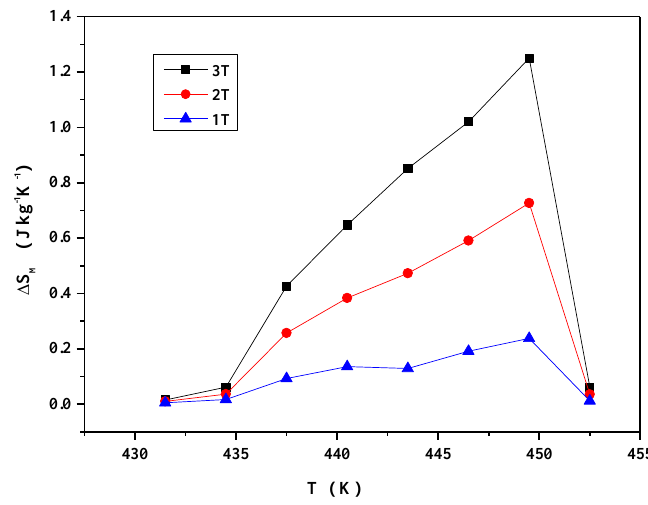
Figure 20. The magnetic entropy changes as a function of temperature under 3 T, 2 T, 1 T magnetic fields for the Ni 2 − x Co x In 3 (x = 0.200) alloy.